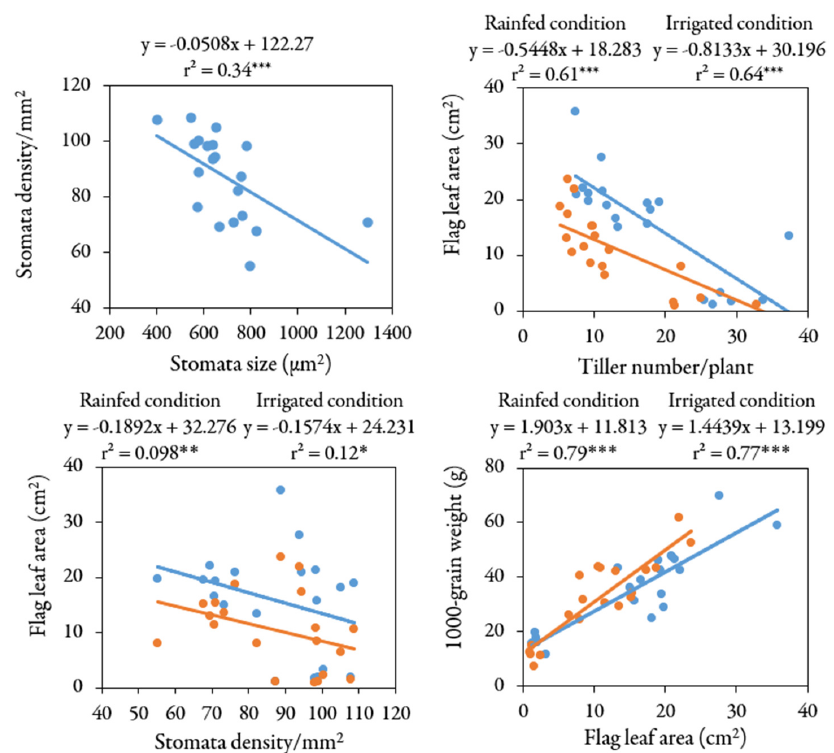
Figure 4. Relationship between/within stomatal and morphological traits of the studied genotypes “*” indicates P < 0.05, “**” for P <0.01, and “***” P